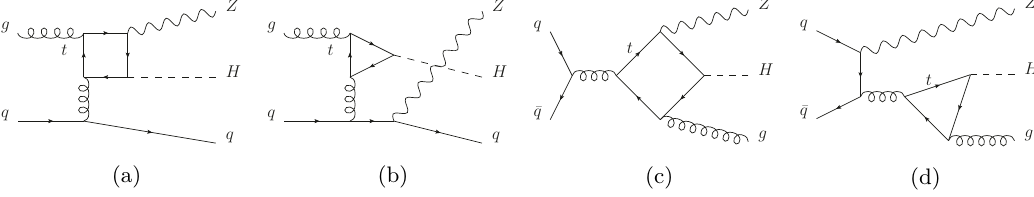
Figure 2. Representative Feynman diagrams for the qg and q ¯ q channels. In (b) and (d) examples of Z -radiated diagrams (see section 3) are depicted.